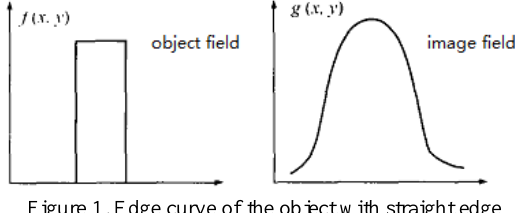
Figure 1. Edge curve of the object with straight edge The slope of edge curve reflects the blurriness of the edge, so we can measure the definitions of image regions by the slope of the edge curve. This paper adopted the calculation method of the definition of image regions which Hu et al. (2004)